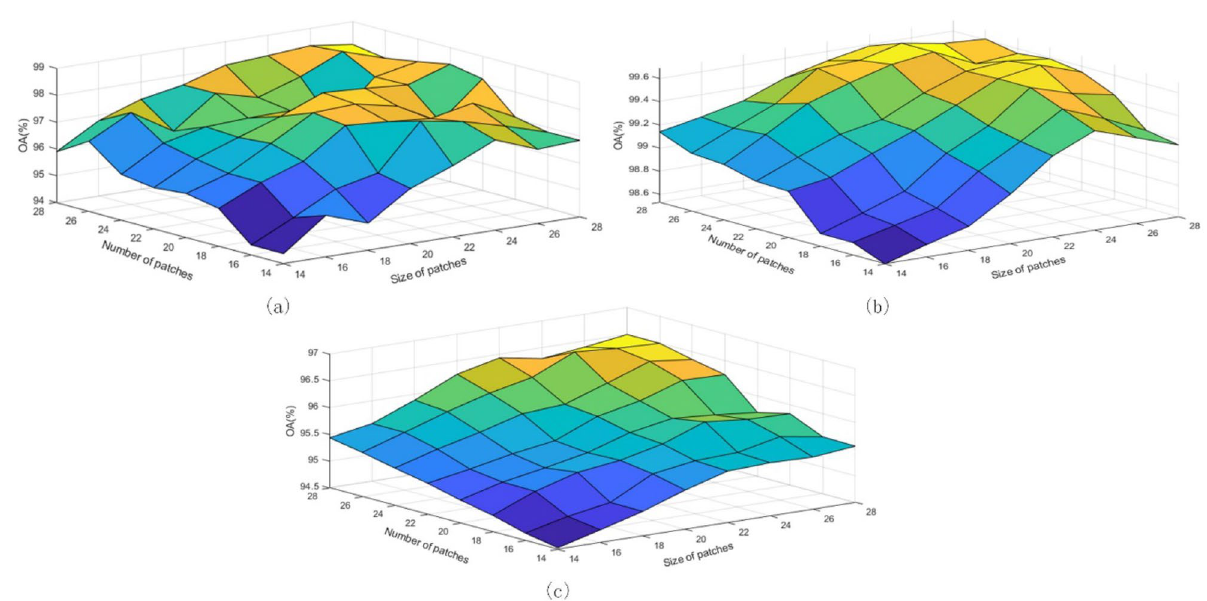
Figure 7. The effect of random patches size and number on classification accuracy on three data sets. ( a ) Indian Pines; ( b ) Pavia University; ( c ) Kennedy Space